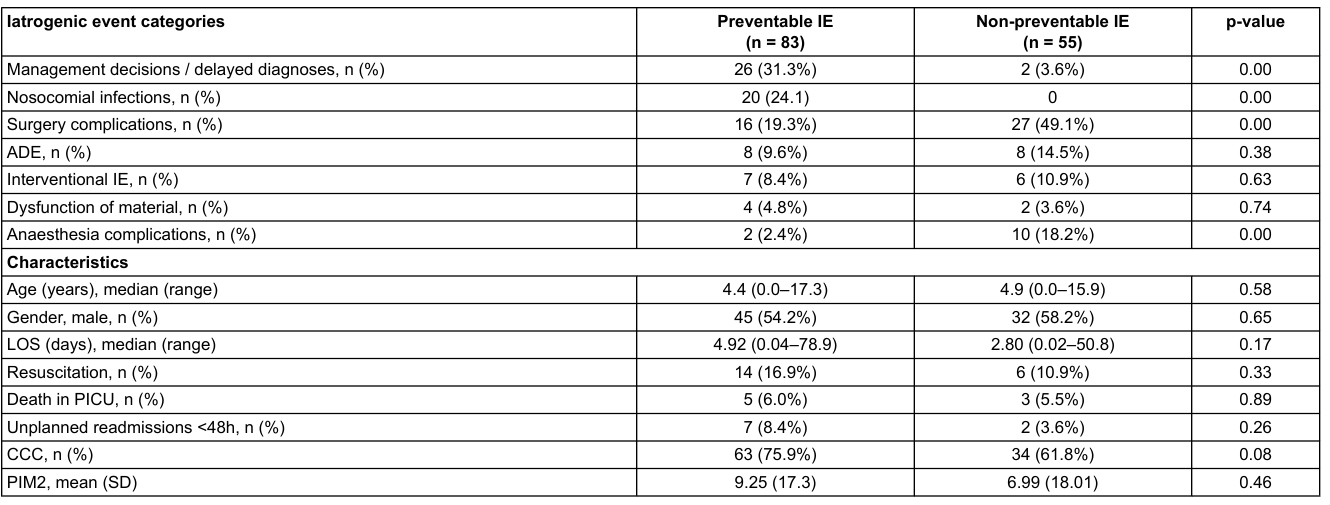
Table 3: Categories and characteristics by preventable vs non-preventable iatrogenic events. Iatrogenic event